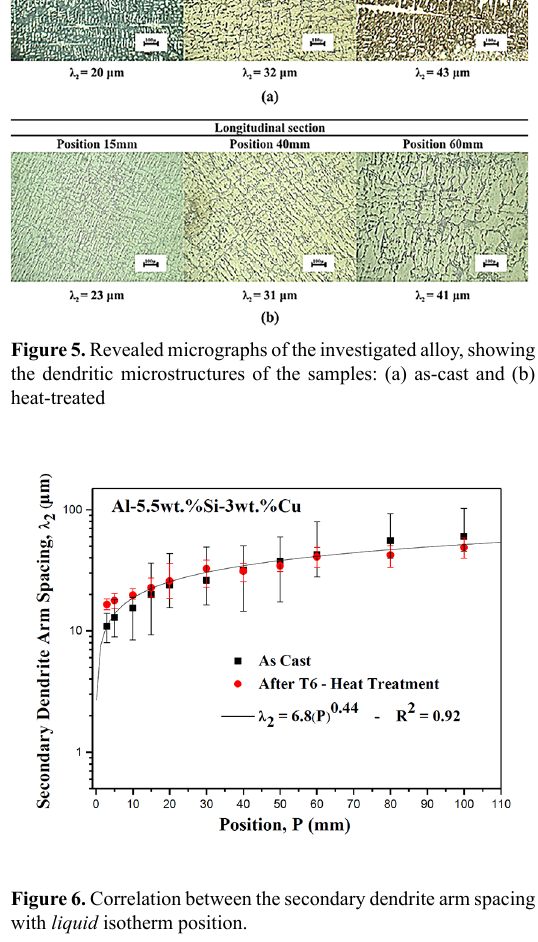
Figure 6. Correlation between the secondary dendrite arm spacing with liquid isotherm